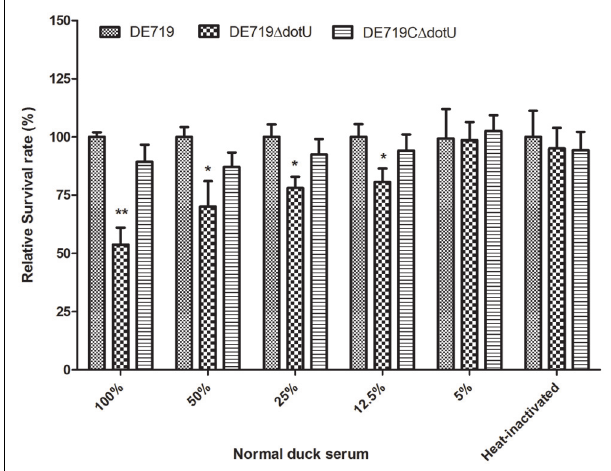
FIGURE 3 | Bacterial resistance to normal duck serum. Bacteria were incubated with the normal duck serum at different dilution at 37 ◦ C, and CFUs were enumerated after 30 min treatment.The data revealed that DE719 (cid:2) dotU showed significant reduction of resistance. ** p < 0.01; * p <